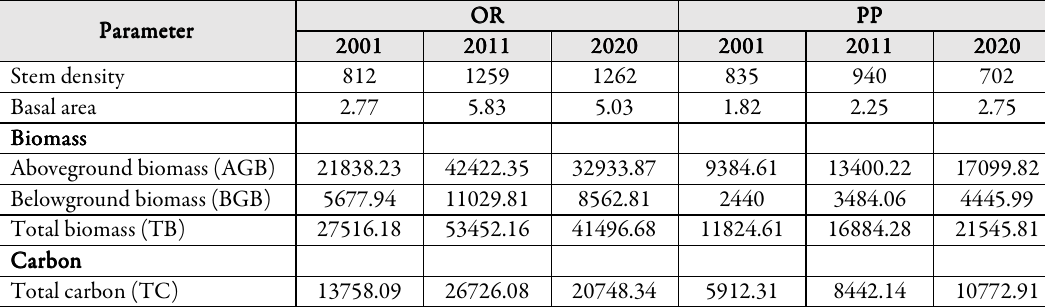
Table 3. Changes in basal area (m 2 ha -1 ), biomass (kg ha -1 ), and carbon stock (kg C ha -1 ) in two forest